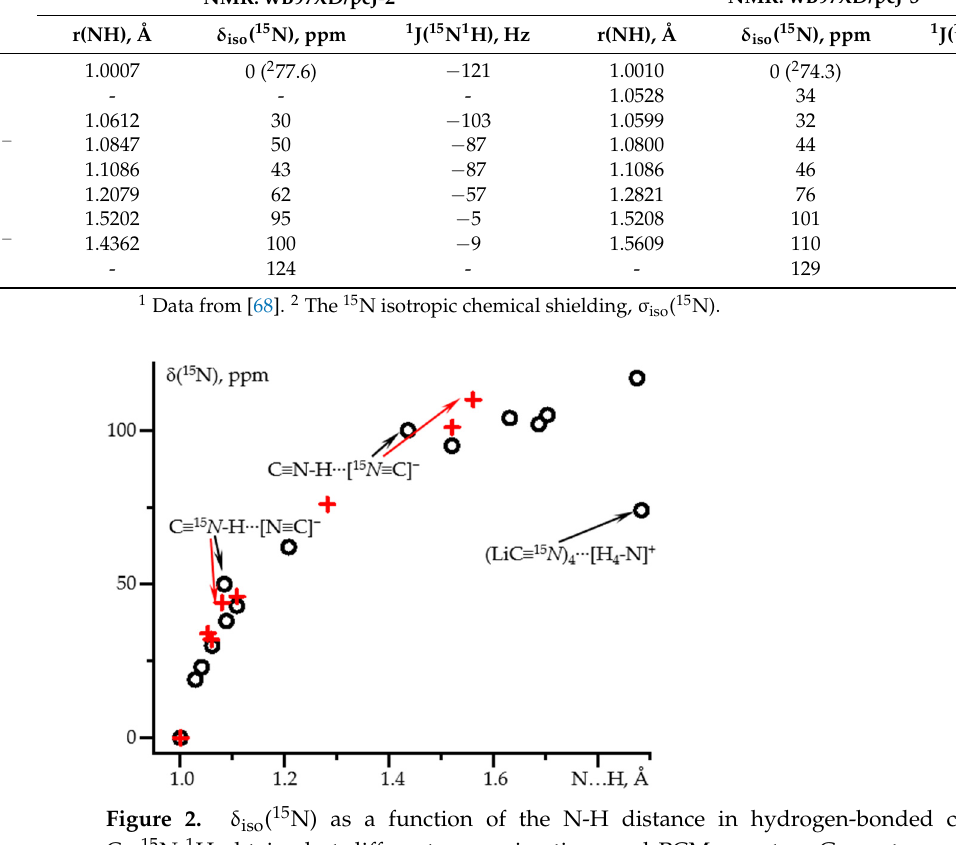
Table 1. The 15 N isotropic chemical shift, δ iso ( 15 N), referenced to free C ≡ 15 N- 1 H at 0 ppm and the 15 N- 1 N scalar coupling constant, 1 J( 15 N 1 H), as functions of the N-H distance in hydrogen-bonded complexes of C ≡ 15 N- 1 H obtained at different approximations and PCM = water.